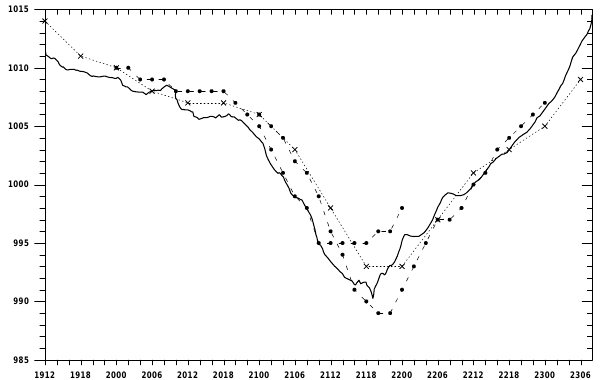
Fig. 9. Evolution of the surface pressure at Palma as recorded by the INM station (strong black line), as analysed by the ECMWF (crosses) and as simulated by the model (filled circles). Two simu- lations are depicted, C20–22 and